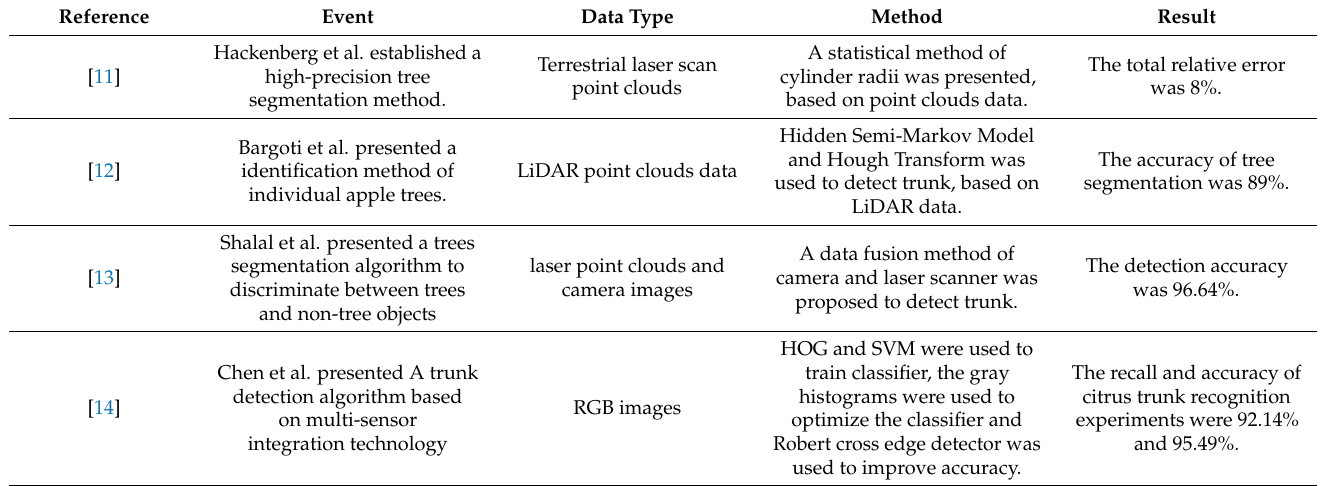
Table 1. Summary of references regarding trunk segmentation methods based on different data